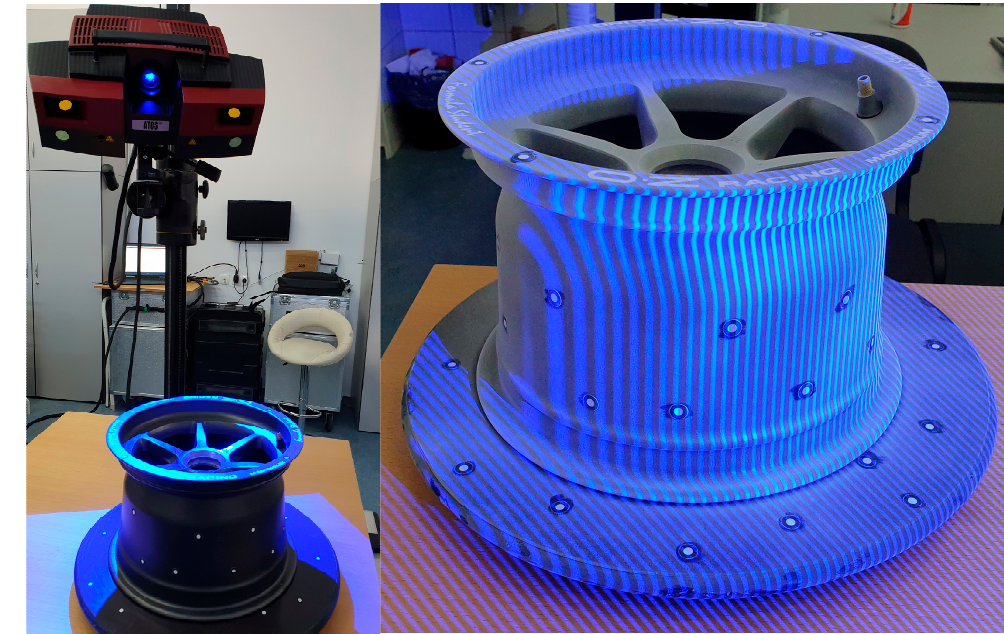
Figure 4. The GOM ATOS TripleScan II system and the projected light trail pattern example.